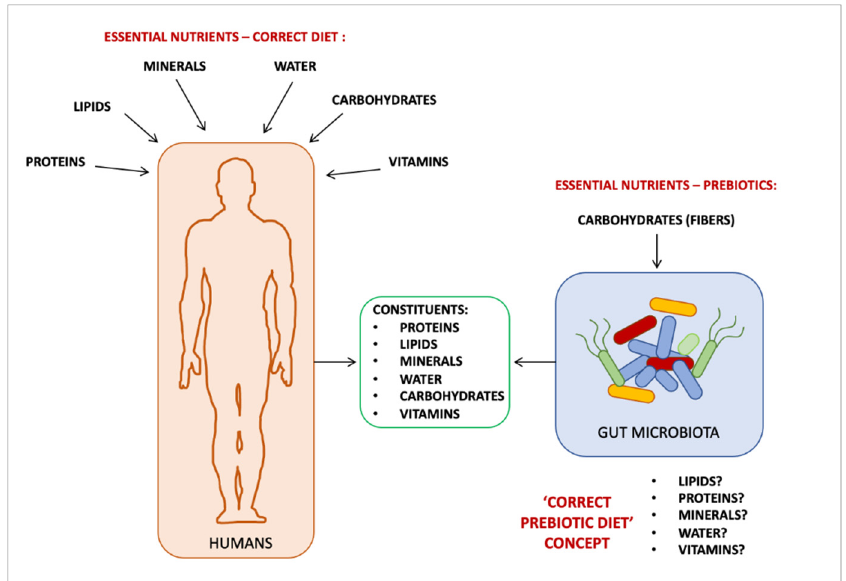
Figure 2. The ‘correct prebiotic diet’ concept.